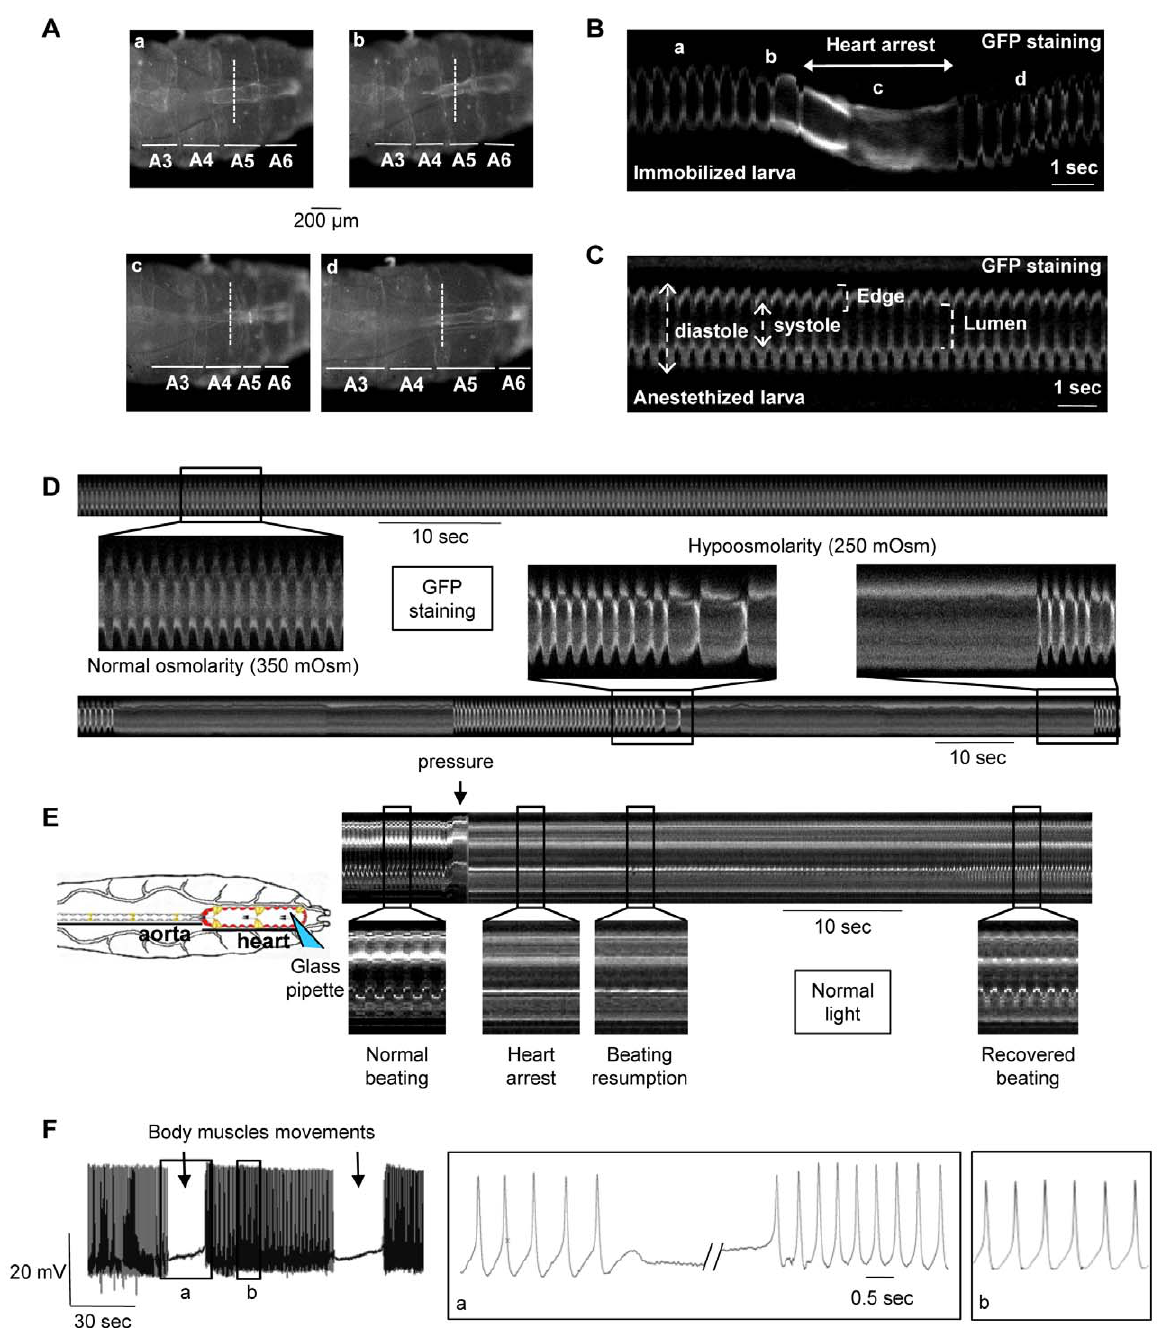
Figure 1. Mechanosensitive response of the cardiac tube in control ( y , w ; CS 6 1029-Gal4) larvae. Heart movement detection is followed during larval motion of a larva immobilized on double-faced tape. Single movie frames (A, posterior is Right) and m-mode traces (B) are extracted from the Video S3. The m-mode trace, excised at the same position (dotted line) in all movie frames, displays a regular frequency (170 bpm) in absence of larval motion (a). When the larva attempts to crawl, the frequency decreases (b) and a 2 sec-cardiac arrest in diastole occurs during the maximal shortening of the larva (c). The basal frequency is recovered shortly following larval relaxation (d). (C) M-mode trace is extracted from the Video S2 of a typical anaesthetized larva. The cardiac tube displays a regular rhythm (170 bpm). (D) Hypoosmotic shock in semi-dissected cardiac tube. (Top) M-mode trace in normal osmolarity displays a regular rhythm (160 bpm). (Bottom) A 20% decrease in frequency is observed after 10-sec exposition to hypoosmotic solution. One minute after, periodic pauses (30–40 sec) in diastole occur after strong bradycardia and the heart restarts spontaneously at the end of the pause. (E) Direct mechanical pressure exerted on semi-dissected cardiac tube. The cardiac tube is submitted to a local pressure (posterior part of A6 segment) with a fire-polished pipette as indicated in the schematic drawing. The heartbeat is regular before the pressure, then stops when the pressure is applied and restarts slowly 15 sec after the removal of the pipette. Basal frequency is recovered after 30 sec. (F) Action Potential (AP) recording in a semi-dissected cardiac tube. The microelectrode is implanted in the posterior part of the A6 segment. Stable and reproducible APs were recorded with the characteristics previously described for Drosophila larvae [11]. APs stop during body muscles contraction concomitant with cardiac arrest in diastole, and a slow membrane depolarization is recorded until the depolarization phase of the next